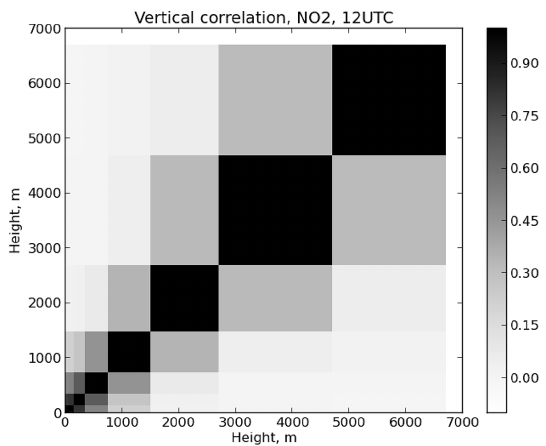
Figure 2. Vertical correlation function for NO 2 at